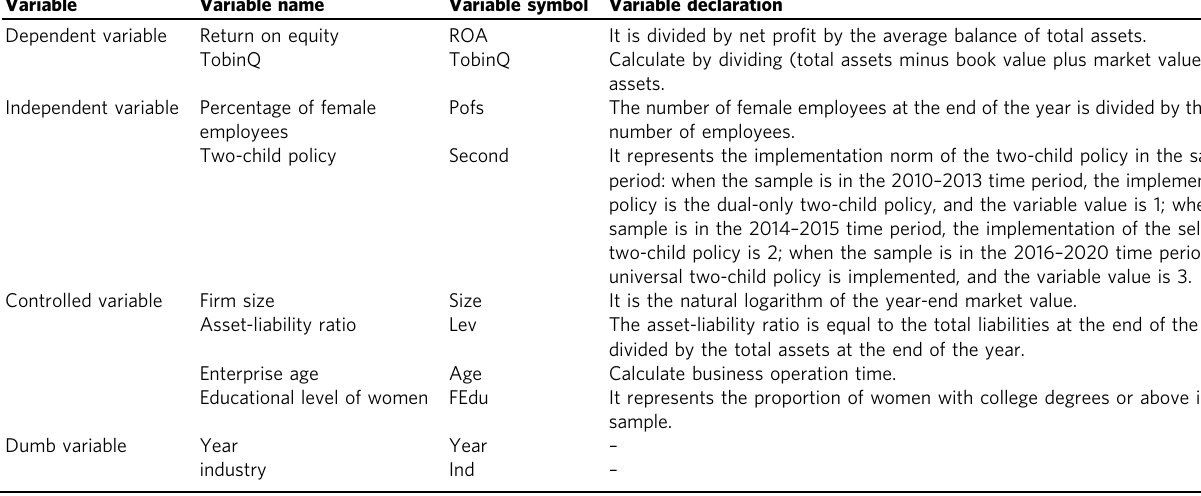
Table 2 Variable de fi nitions.